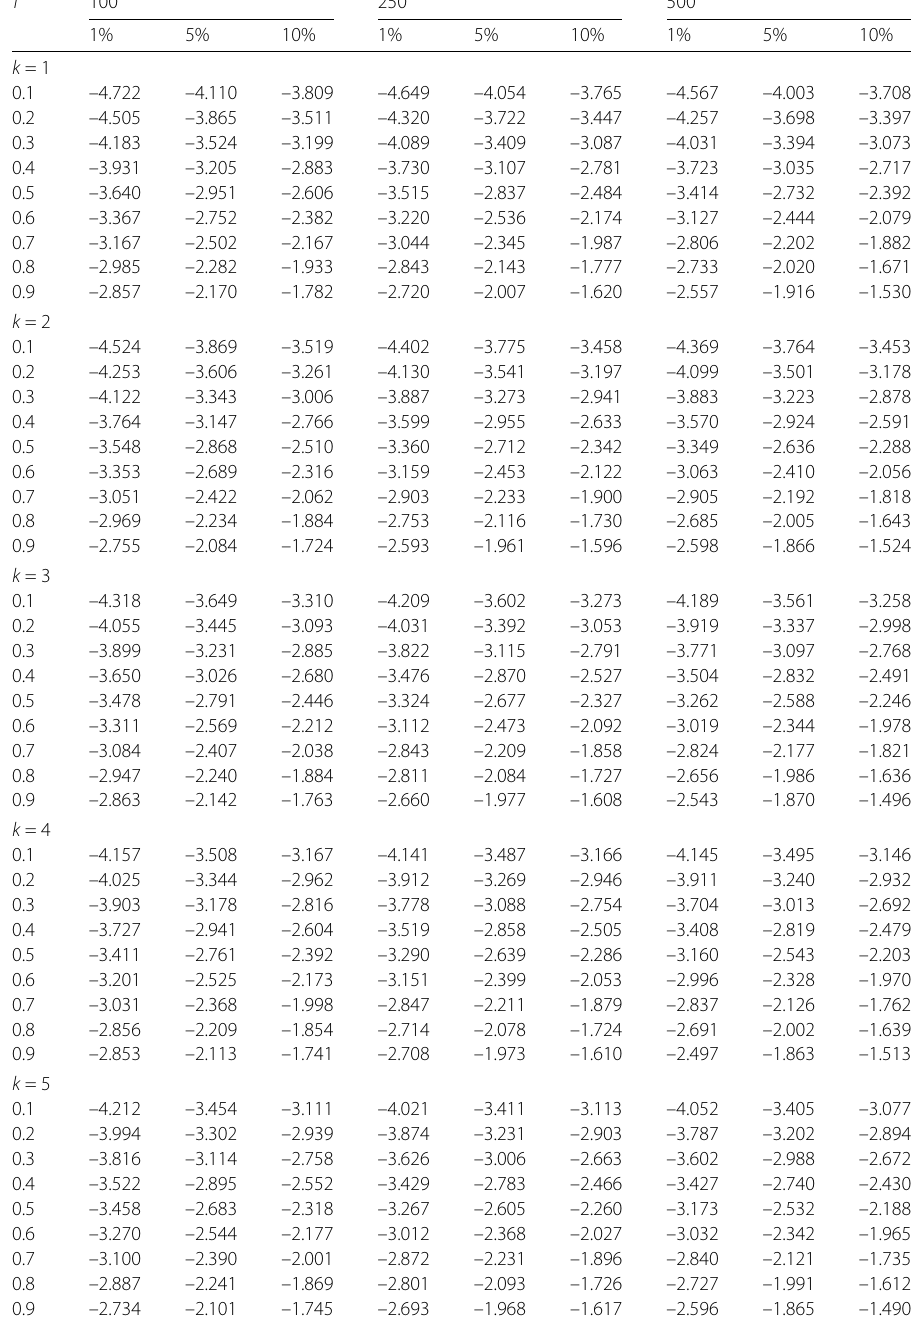
Table 2 Critical values for FI models intercept and trend included in integer Fourier